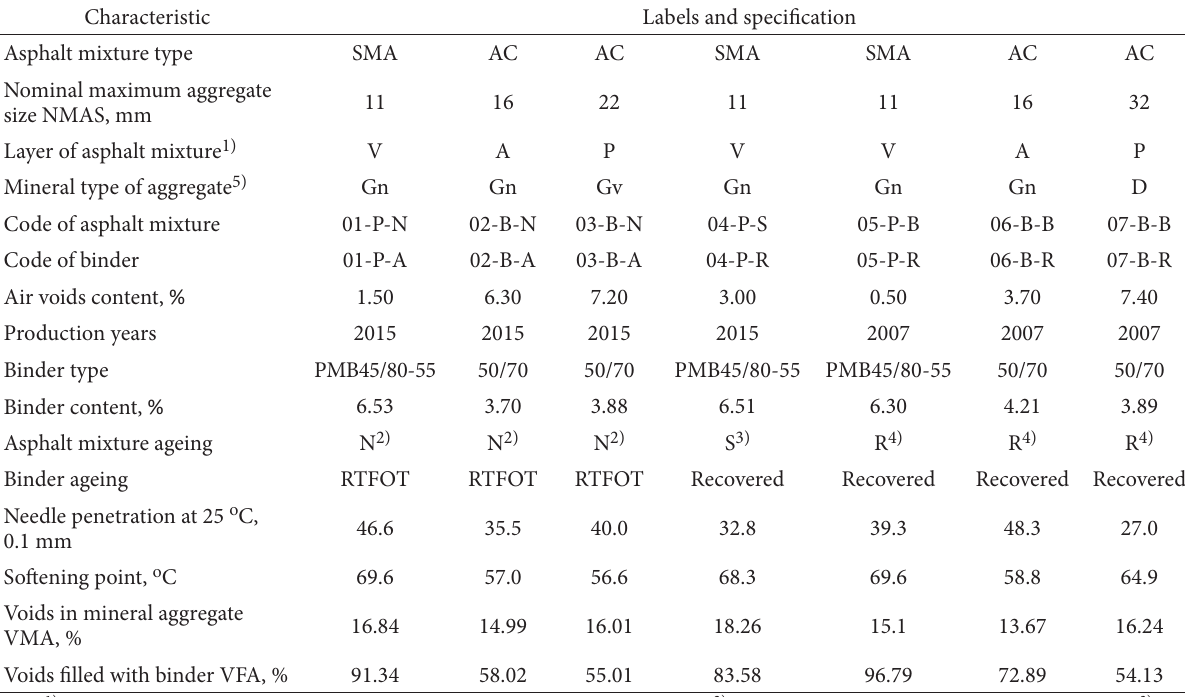
Table 1. The specification of asphalt mixtures and bitumen binders Characteristic